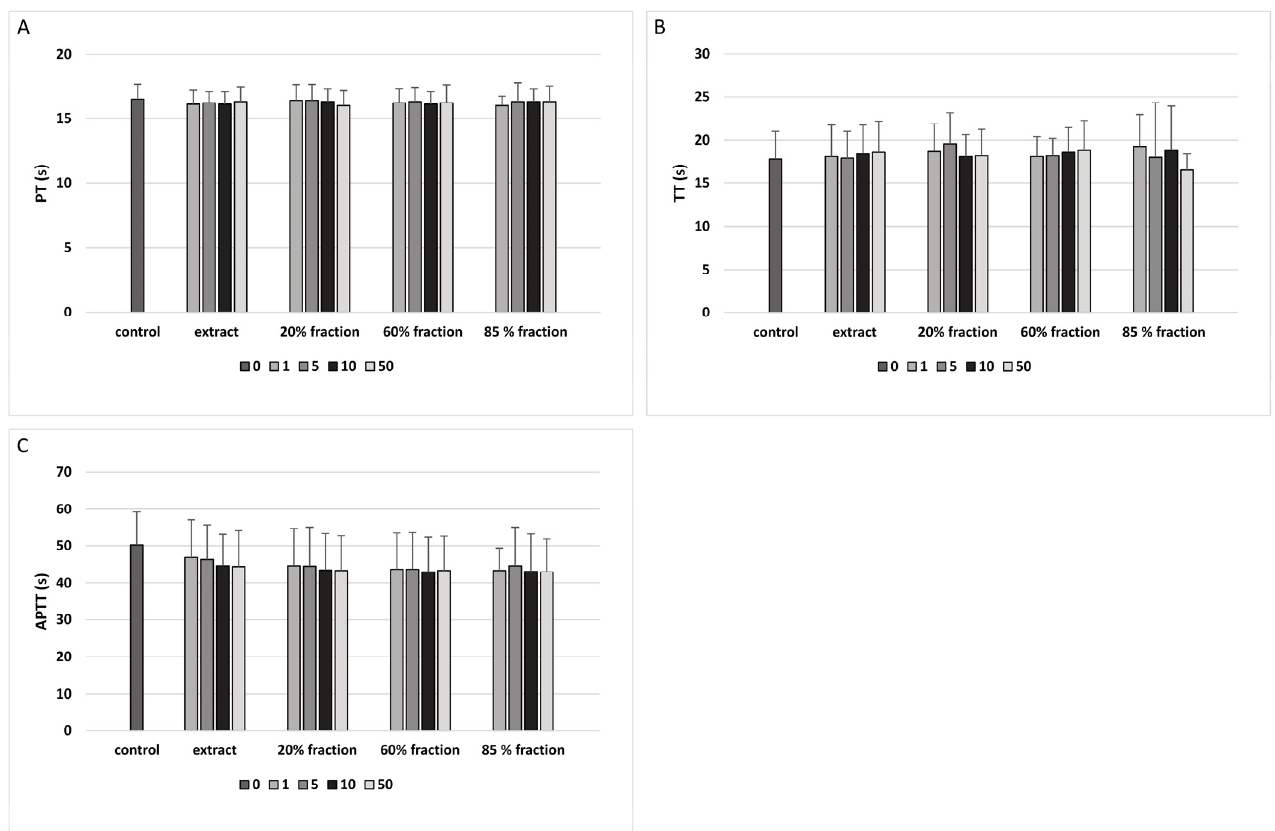
Figure 1. The effect of the extract and three fractions (20%, 60% and 85%; concentration range: 1–50 µg/mL; incubation time: 30 min) on the hemostatic parameters of human plasma: PT ( A ), TT ( B ), and APTT ( C ). Data represent means ± SD of 6 experiments; p > 0.05 (compared with control). The extract and 85% fraction at the highest used concentration—50 µ g/mL—inhibited plasma lipid peroxidation induced by H 2 O 2 /Fe 2+ (Figure 2A). As demonstrated in Figure 2B, extract and two fractions (20 and 60% fraction; at the highest used concentration—50 µ g/mL) reduced plasma protein carbonylation stimulated by H 2 O 2 /Fe 2+ . In addition, 85% fraction (at three concentrations: 5, 10, and 50 µ g/mL) also inhibited protein carbonylation. At the highest concentration (50 µ g/mL), protein carbonylation was decreased by approximately 50% compared to human plasma treated with only H 2 O 2 /Fe 2+ (Figure 2B).